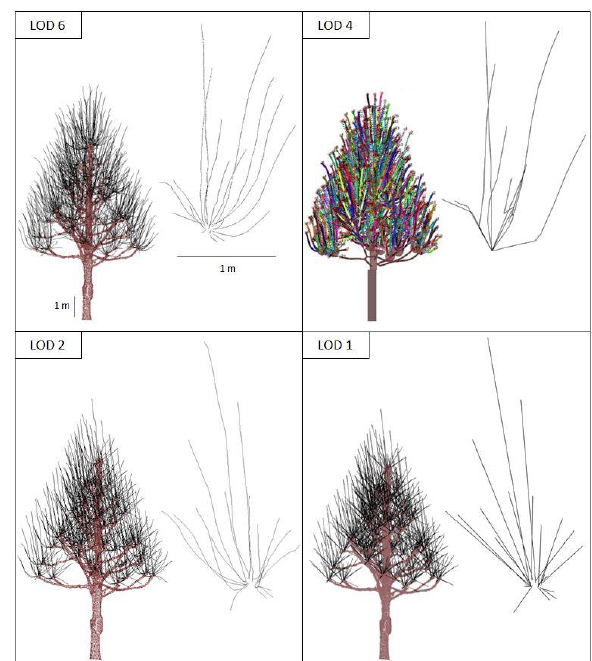
Figure 6. 3D tree models with different LOD (tree on the left and cat’s head on the